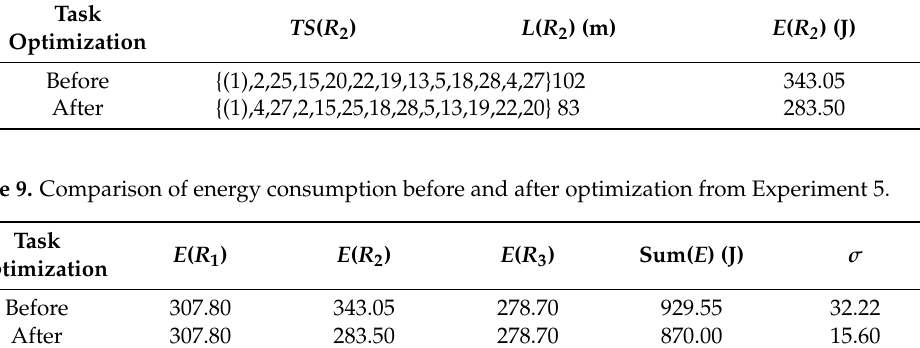
Table 9. Comparison of energy consumption before and after optimization from Experiment 5.